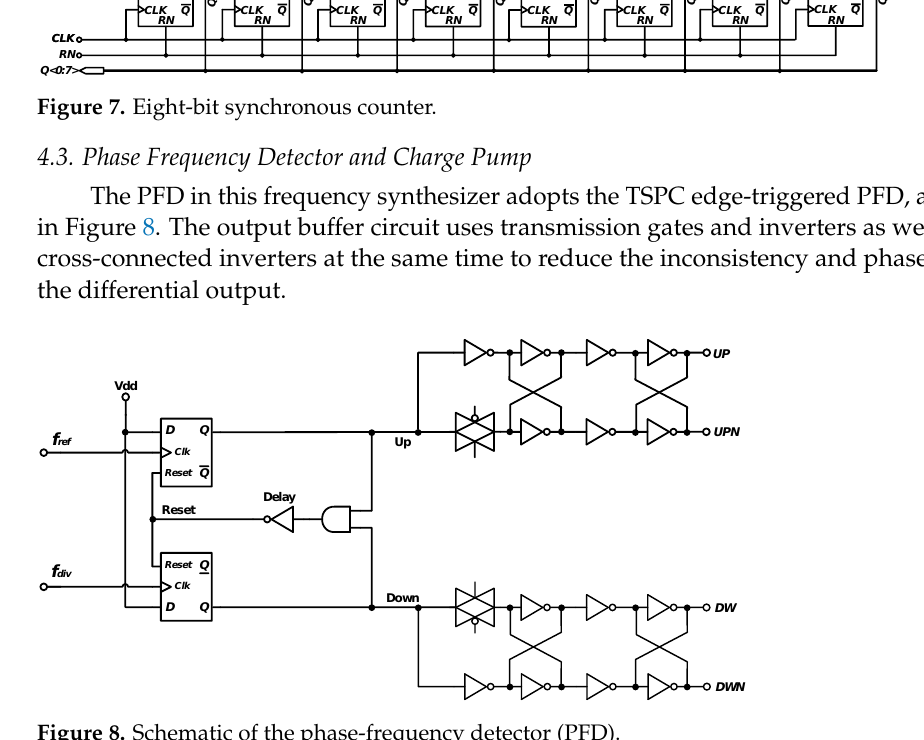
Figure 8. Schematic of the phase-frequency detector